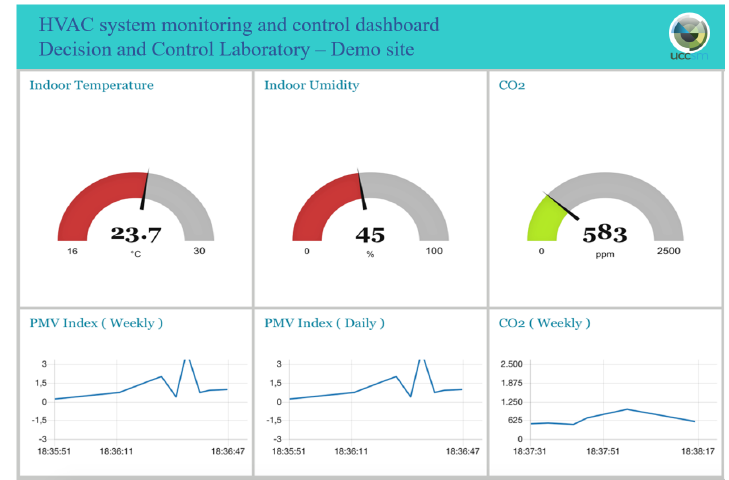
Figure 5. Excerpt of the monitoring and control dashboard prototyped for the demo